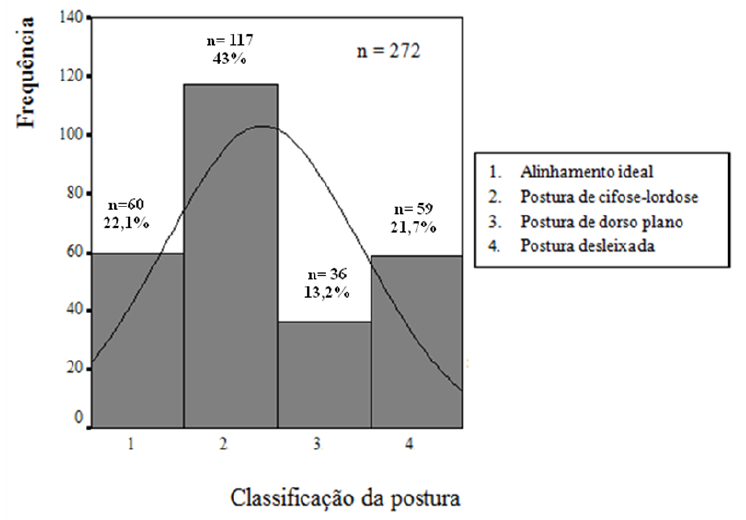
Figura 1. Classificação da postura corporal das idosas participantes do